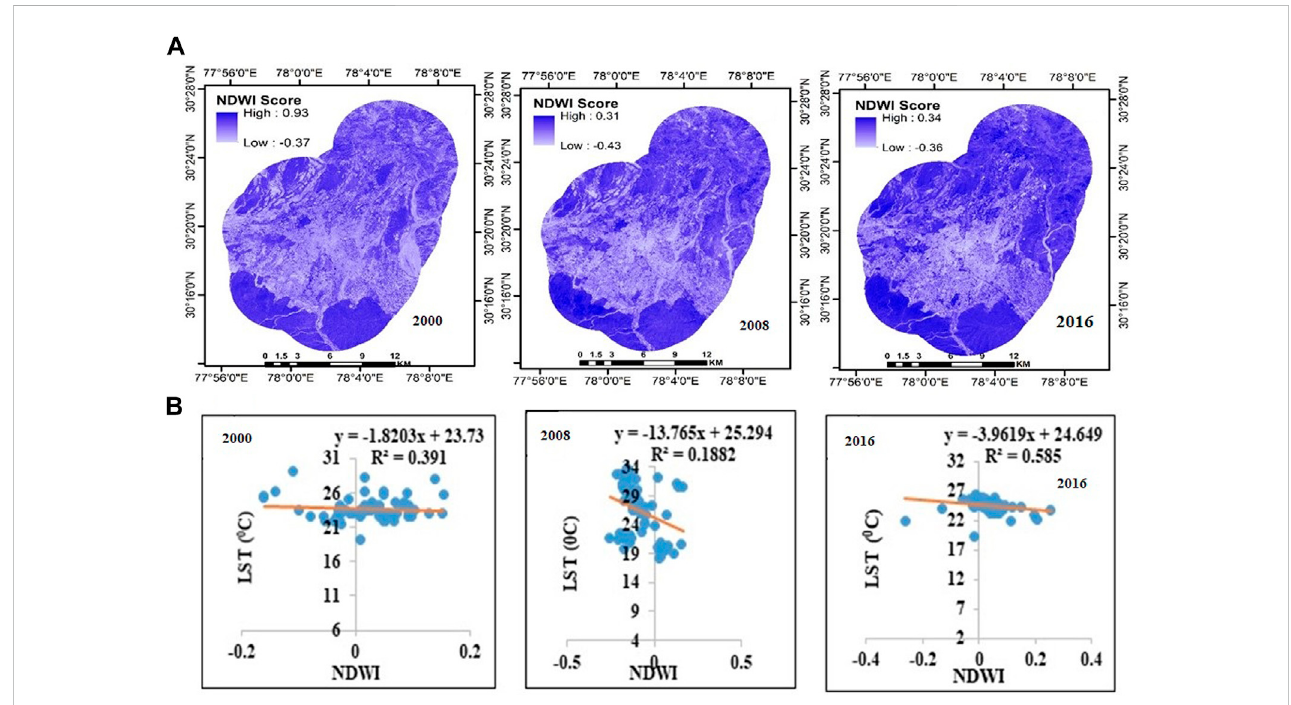
FIGURE 8 Change in NDVI (A) and degree of association of NDVI with LST (B) for Dehradun.